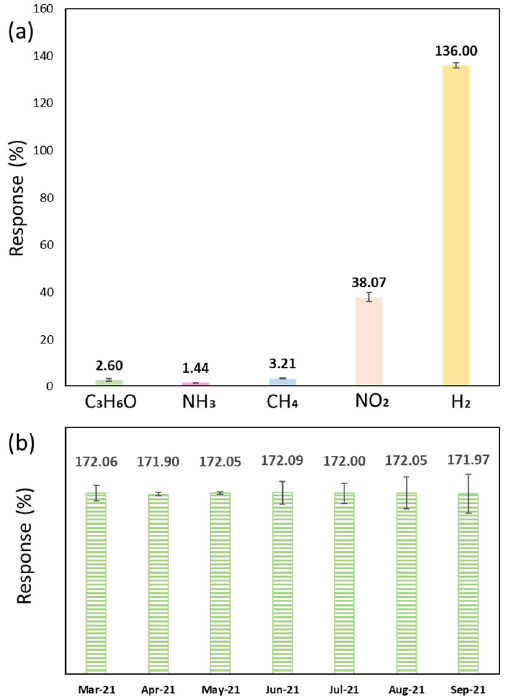
Figure 10. ( a ) Gas selectivity of the CeO 2 -Pd-PDA/rGO sensor at 100 °C and 0% RH towards different gases at 50 ppm; ( b ) long-term sensor stability towards 6000 ppm H 2 at 100 °C and 0% RH over seven months.